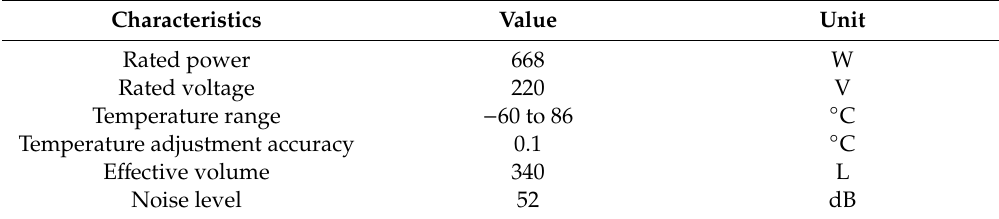
Table 6. Key specifications of the low-temperature test